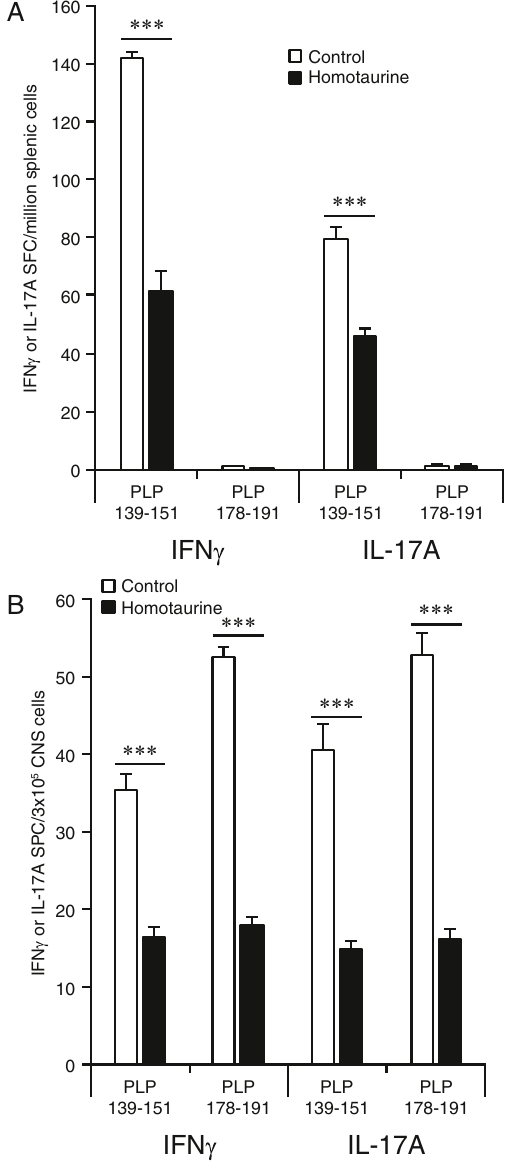
Figure 3. Homotaurine treatment limits the spreading of T cell autoreactivity within the CNS. SJL mice were immunized with PLP 139-151 and 15 days later, near the first peak of clinical symptoms, mice were placed on plain water or containing homotaurine (0.25 mg/ml) for the rest of the experiment. Thirty days later, we analyzed the frequency of T cells which secreted IFNγ or IL-17A in response to PLP 139-151 and PLP 178-191 in the spleens (panel A) or CNS (panel B) of individual mice by ELISPOT. N = 6 mice/group. ***p < 0.001 by Student’s